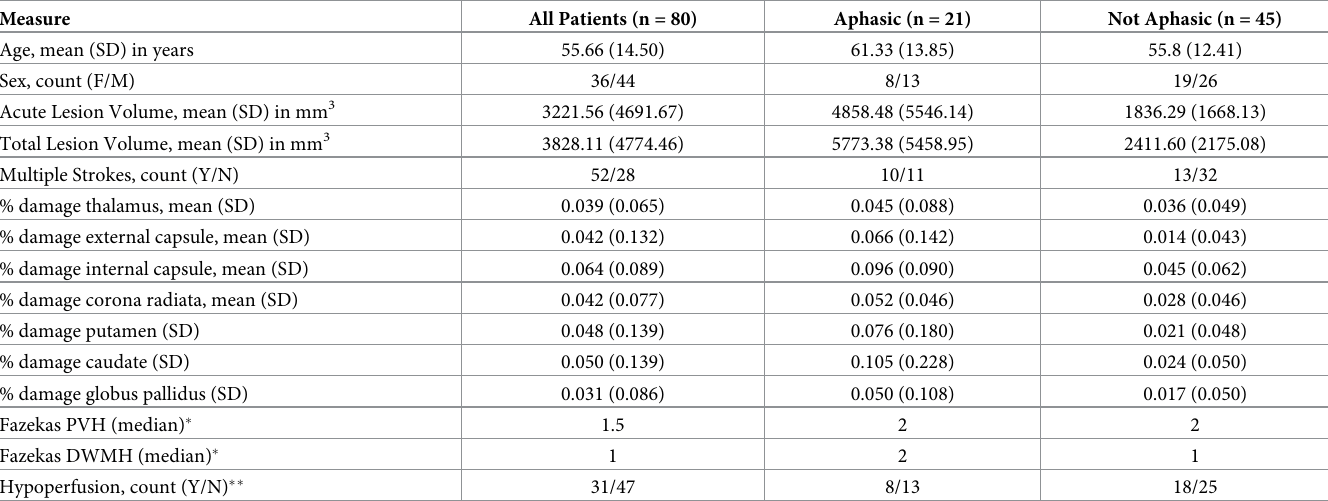
Table 1. Demographic and stroke variables compared between aphasic and non-aphasic